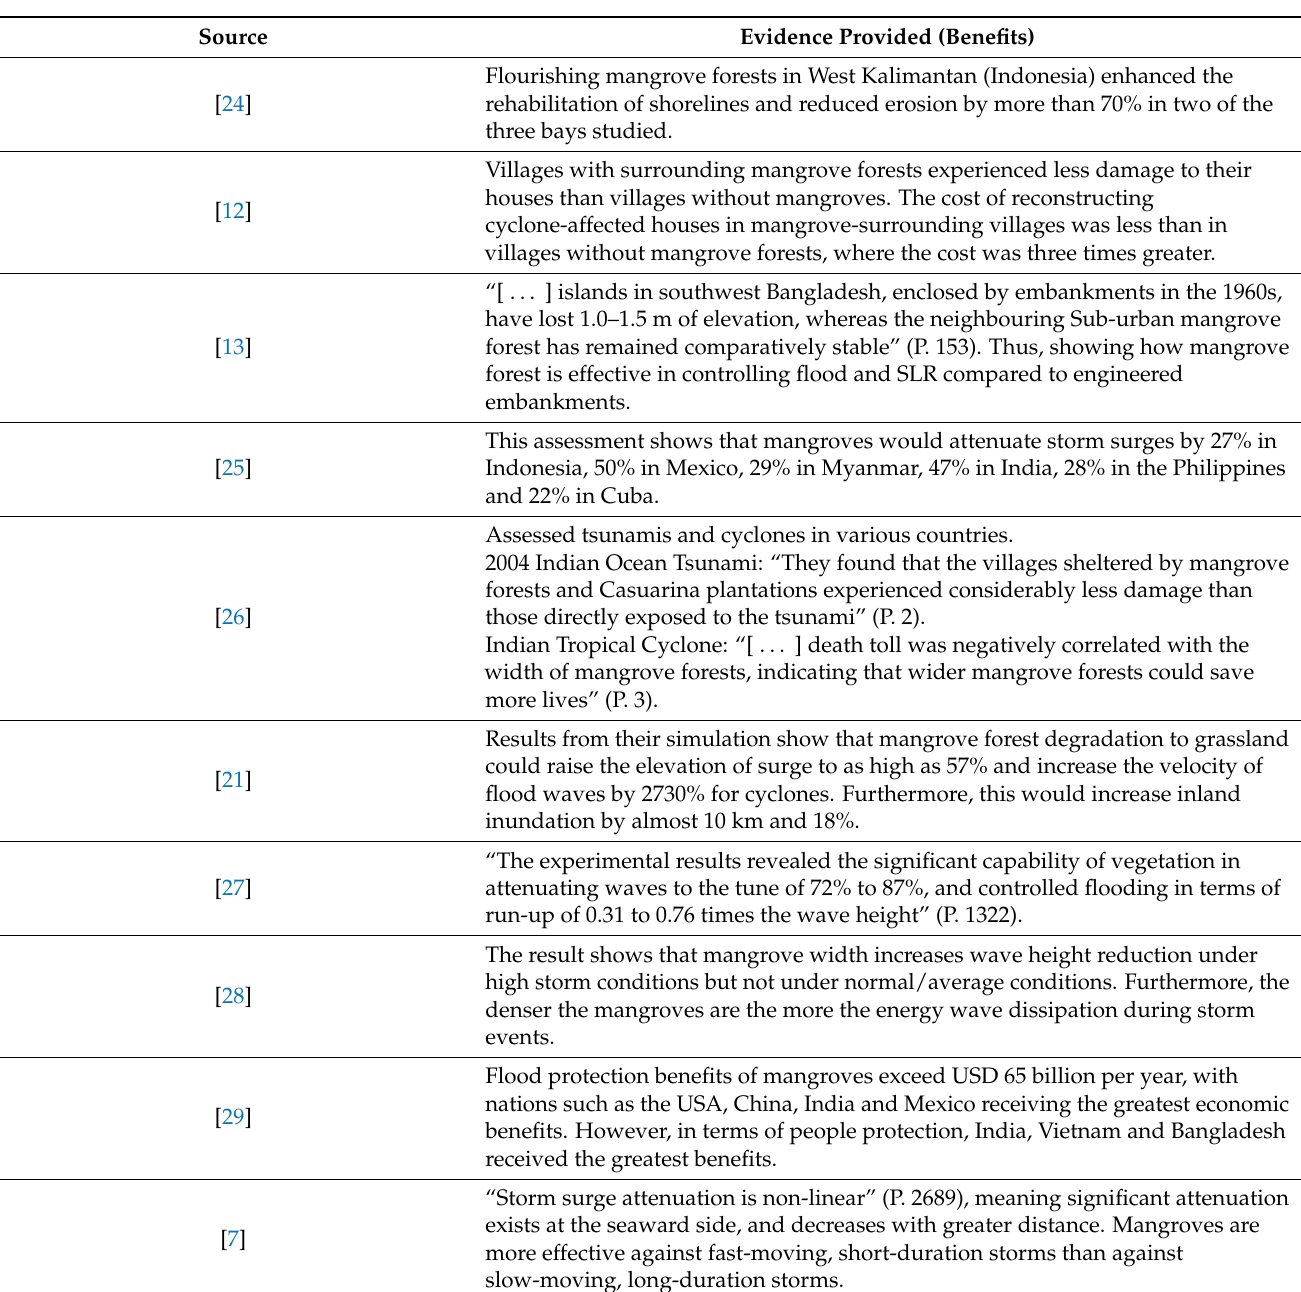
Table 2. Scientific evidence (benefits) from selected